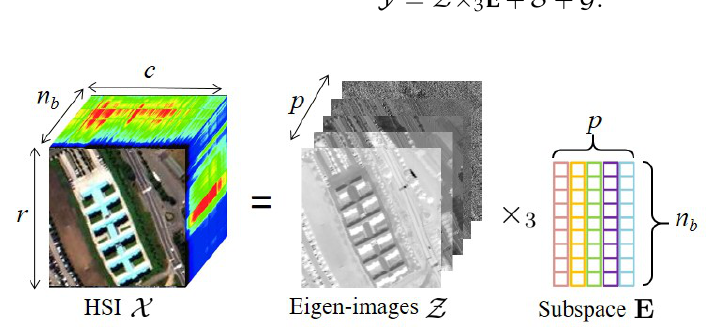
Figure 2. Subspace representation of a hyperspectral image. The subspace representation of spectral vectors has been demonstrated to be a pow- erful tool for solving some hyperspectral inverse problems, such as hyperspectral image super-resolution [33], hyperspectral image segmentation [34], hyperspectral image classifi- cation [35], and hyperspectral unmixing [36]. In this paper, we propose a hyperspectral image mixed noise removal method using subspace representation and deep CNN Image prior ( HySuDeep ), the flowchart of which is illustrated in Figure